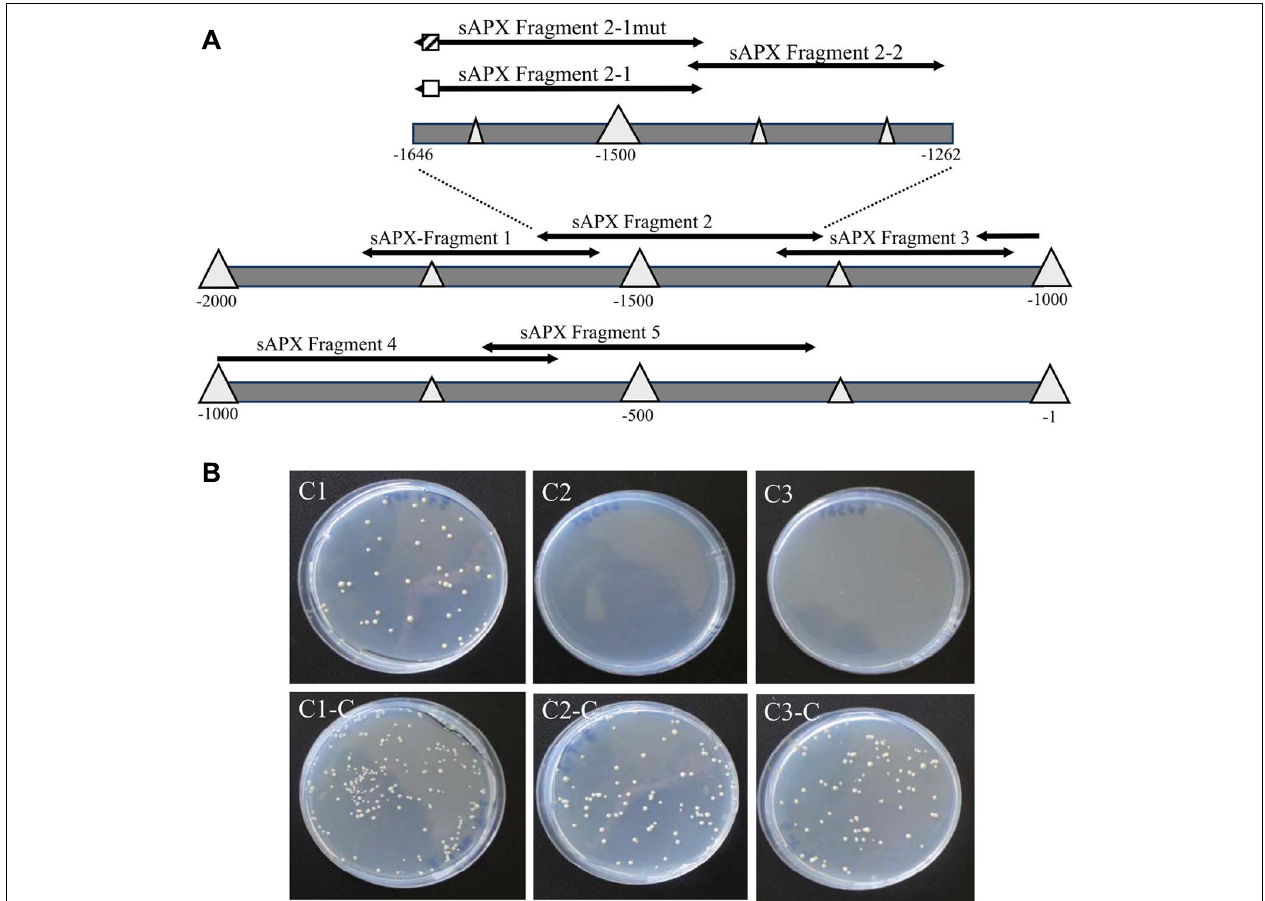
FIGURE 2 | Schematics of the promoter of sapx used for yeast- one-hybrid screening and binding to the specific cis -element. (A) Fragment p sapx1 ( − 1563 to − 1868 bp); p sapx2 ( − 1262 to − 1646 bp); p sapx3 ( − 954 to − 1321 bp); p sapx4 ( − 609 to − 1018 bp); p sapx5 ( − 246 to − 691 bp); p sapx6 ( − 1 to − 263 bp). Division of p sapx2 for localization of the ANAC-binding cis -element: pHis2: sapx2 -1/mut ( − 1432 bis − 1646), pHis2: sapx2 -2 ( − 1432 bis − 1451).The potential target element for binding of ANAC089 is marked as hatched and the mutagenized region in white box.